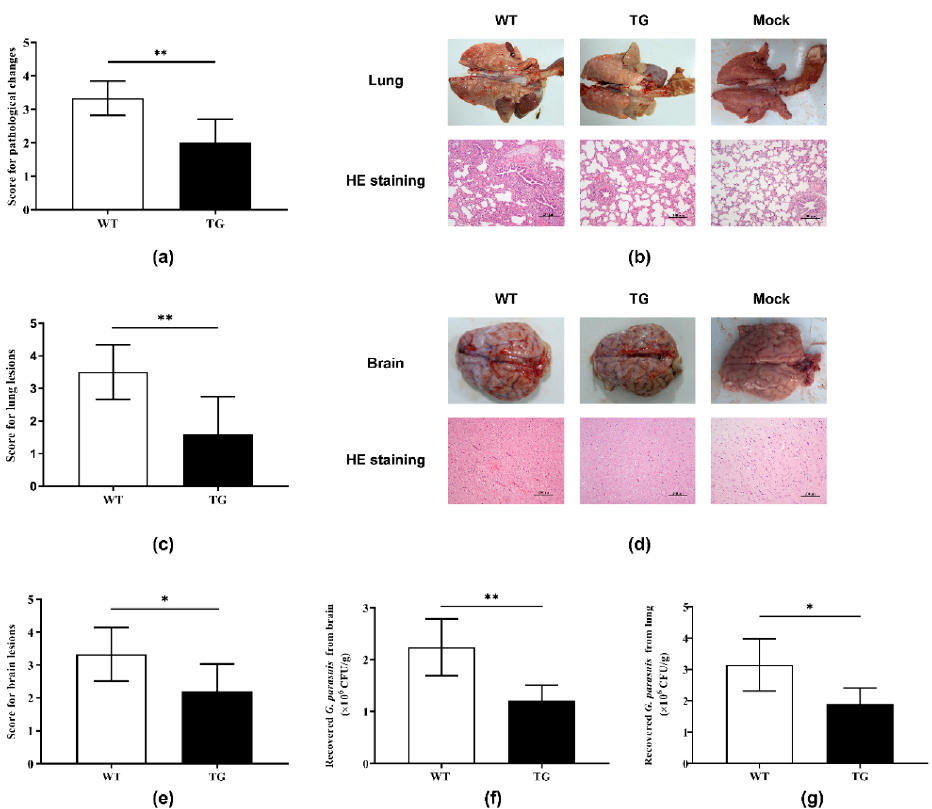
Figure 3. Pigs overexpressing PBD-2 exhibited reduced susceptibility to G. parasuis infection. ( a ) Assessment on the gross pathological changes of WT ( n = 6) and TG ( n = 5) pigs, with higher scores representing greater disease severity. ( b ) Representative macroscopic and microscopic changes of lungs. Mock: pigs without any bacterial infection. ( c ) Scoring for lung lesions caused by G. parasuis infection. ( d ) Representative macroscopic and microscopic changes of brains. ( e ) Scoring for brain lesions caused by G. parasuis infection. ( f ) Bacterial loads of G. parasuis in brain tissues of the pigs. ( g ) Bacterial loads of G. parasuis in lung tissues of the pigs. Data are represented by means ± SD. * p < 0.05; ** p < 0.01, unpaired one-tailed Student ′ s t -test.